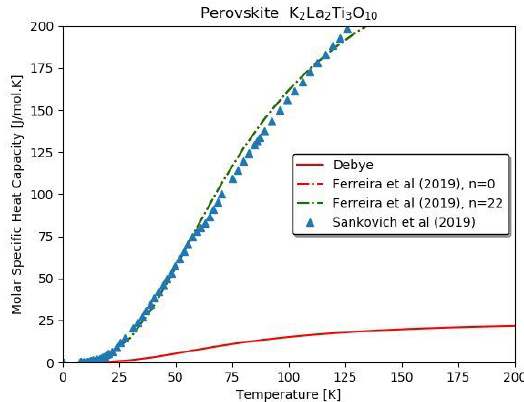
Figure 11. Comparison of the molar heat capacity of perovskite K La Ti O by carrying out Debye, Ferreira et al. 17 model and first 2 2 3 10 dataset of Sankovich et al. 44